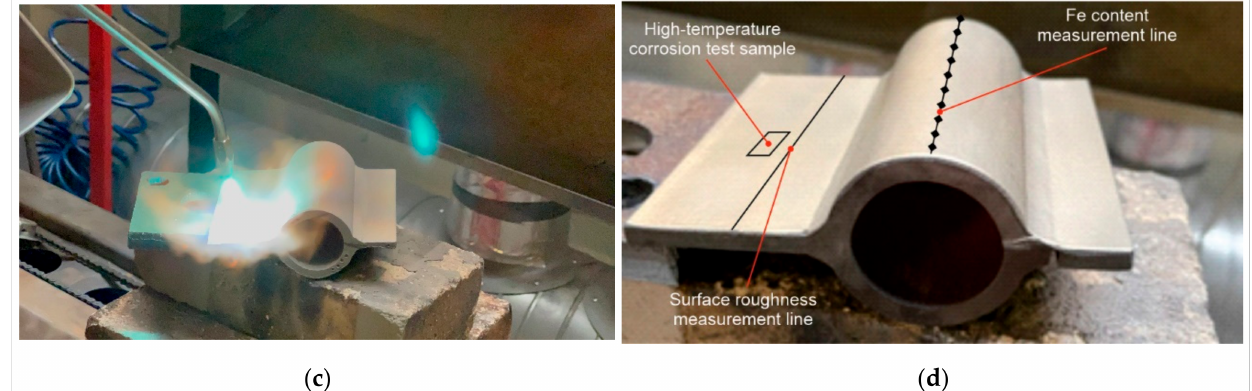
Figure 2. Flame powder spraying process: ( a ) diagram of a manual flame powder spray burner, ( b ) view of a test of flame powder spraying of a remeltable Ni-Cr-B-Si alloy coating using a CastoDyn DS 8000 burner, ( c ) view of the remelting test of the coating sprayed with a self-fluxing powder made of the remeltable Ni-Cr-B-Si alloy, ( d ) view of the sample with the coating protecting against high-temperature corrosion.